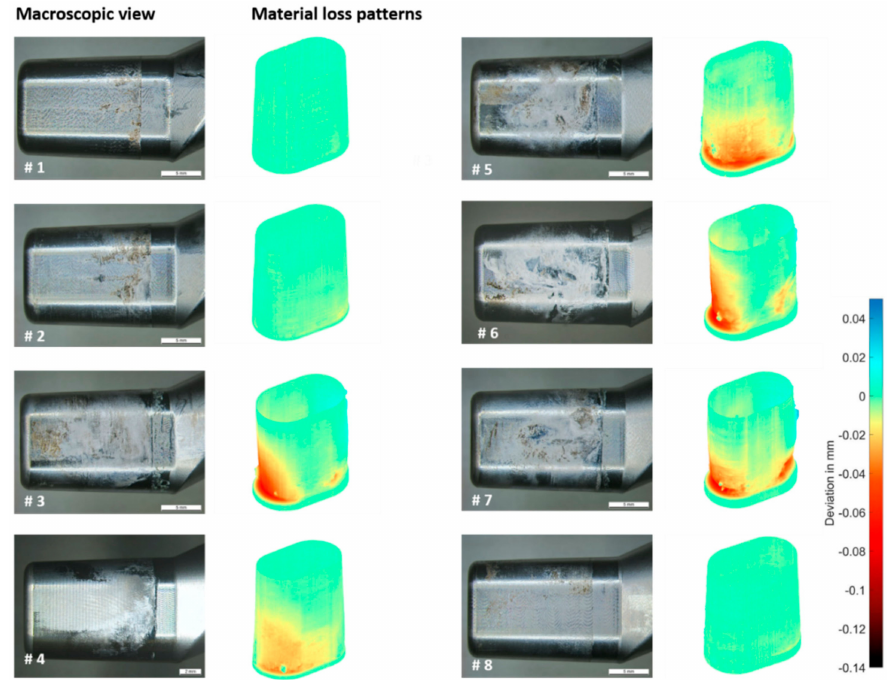
Figure 4. Macroscopic view (left) and volumetric material loss (right) of eight asymptomatic CoCr dual taper neck adapter retrieved after 13–111 months in